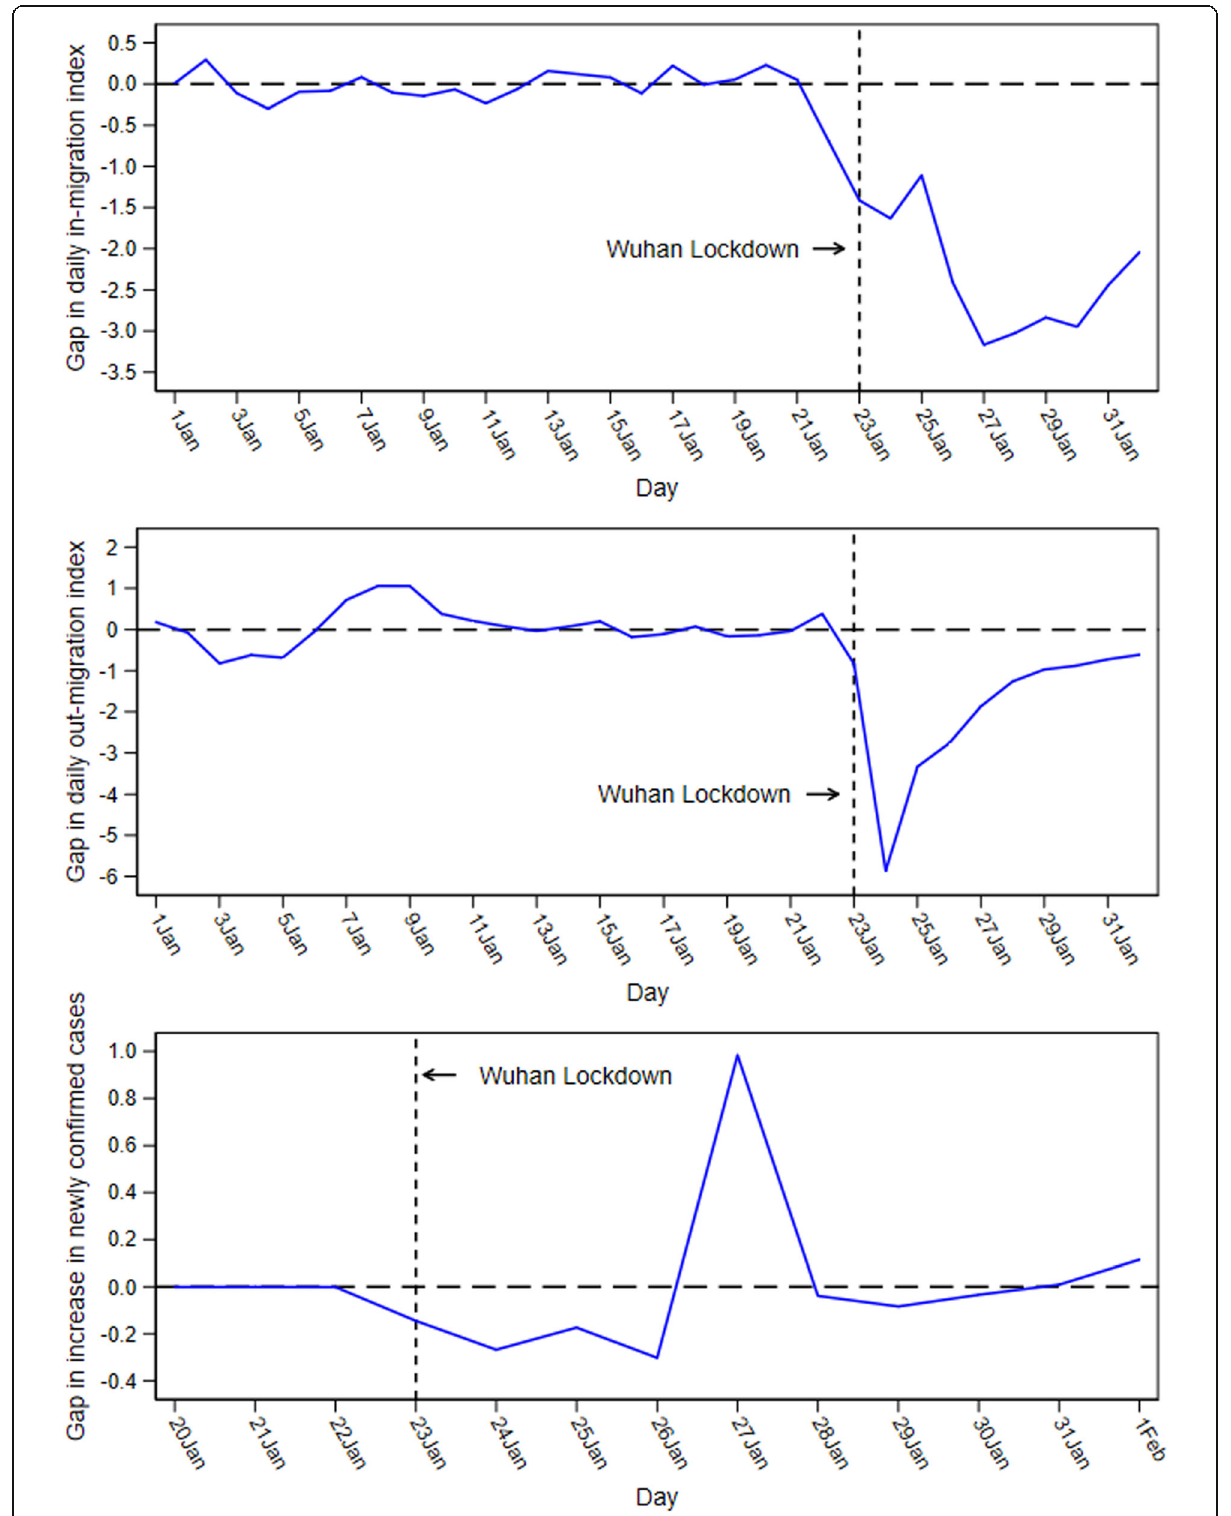
Fig. 3 Gap between Wuhan and Synthetic Wuhan in IMI , OMI , and